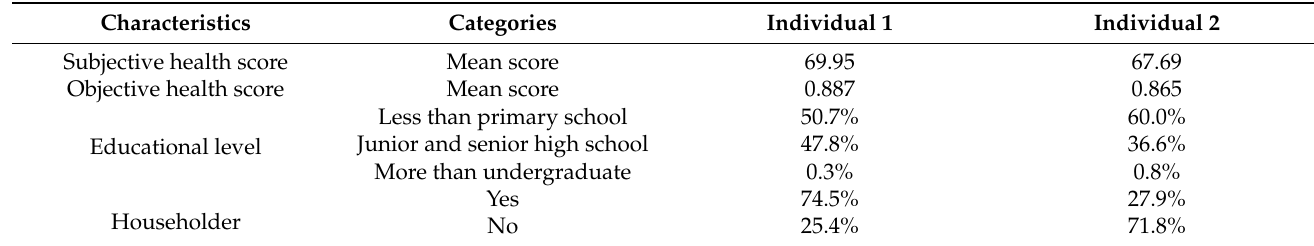
Table 2. Characteristics for each individual in empty nest households ( n =